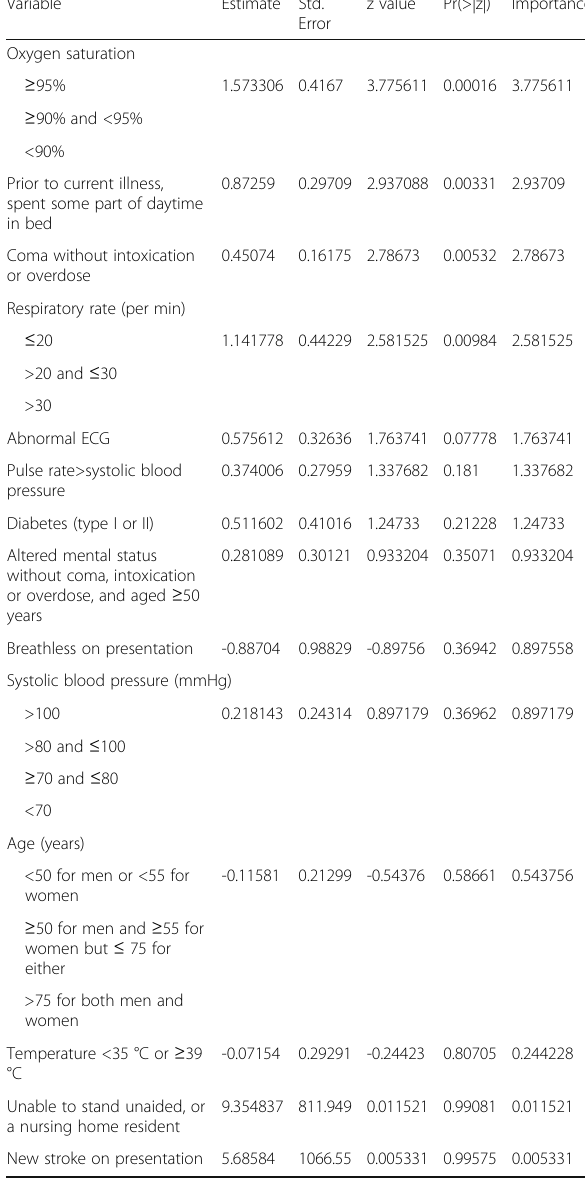
Table 3 (abstract P23). The variable importance for logistic regression model Variable Estimate Std.